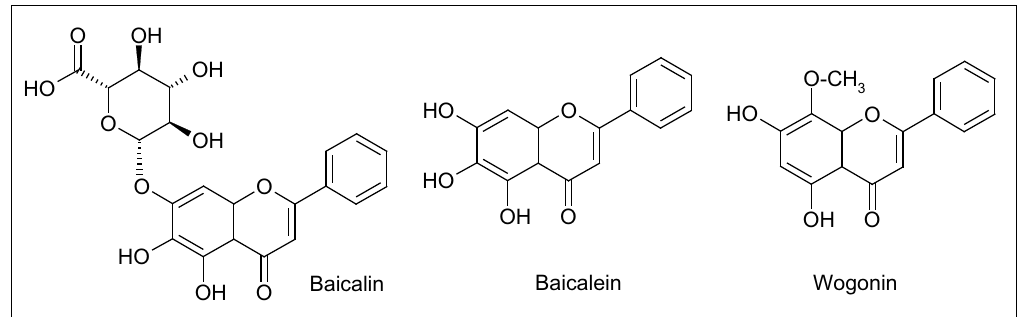
Figure 6. Main flavonoids isolated from Scutellaria baicalensis Georgi